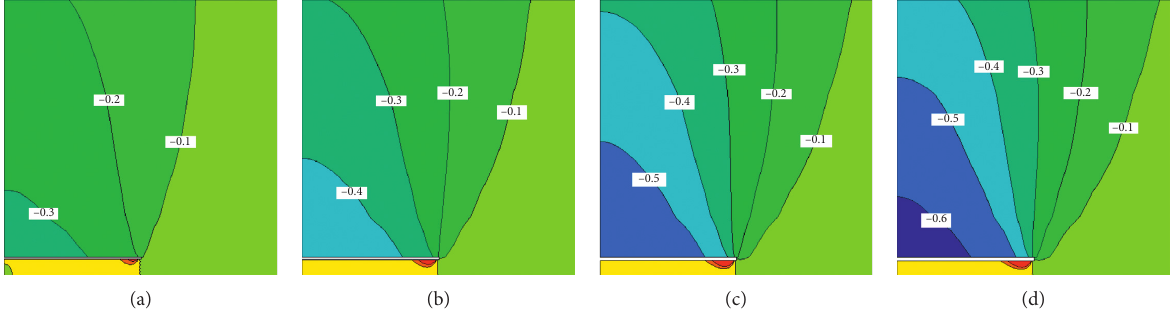
Figure 12: Contour map of vertical displacement of overburden at different mining heights: (a) h � 2.5 m; (b) h � 3.5 m; (c) h � 4.5m; (d) h � 5.0m.